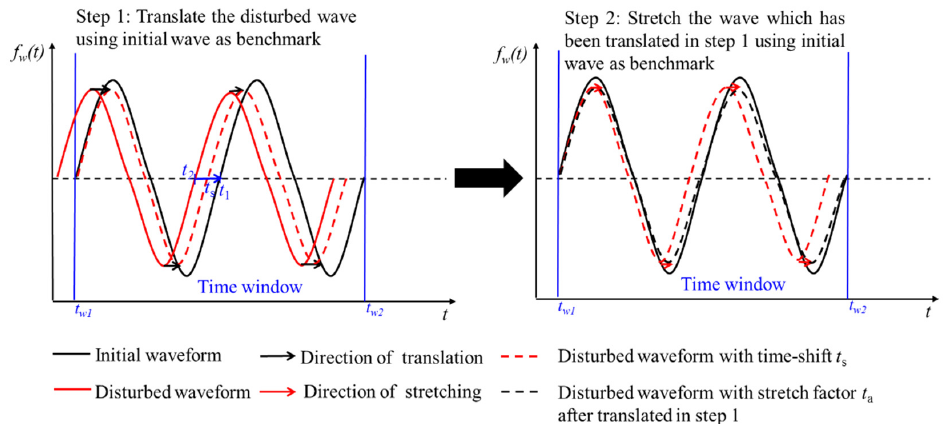
Figure 4. Translating and stretching are both used to calculate time-shift.